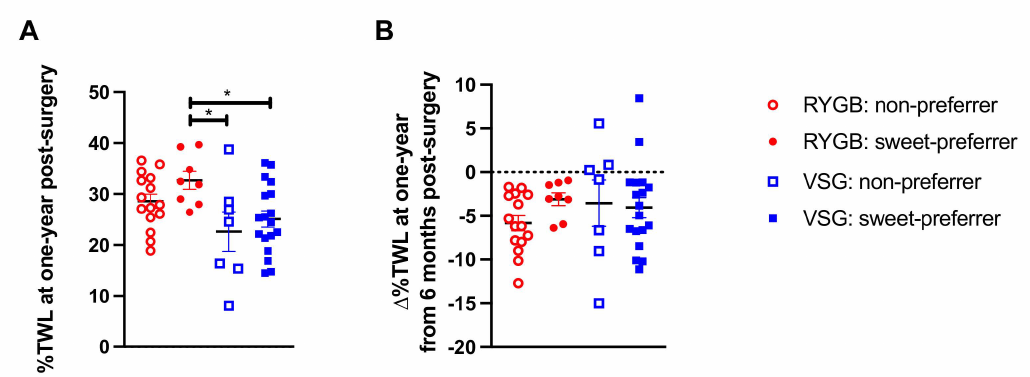
Figure 3. ( A ) Mean ± SEM %TWL at one year following surgery in patients who received RYGB (red circles) or VSG (blue squares) and rated the 10% sucrose-sweetened half-and-half mixture with a 0–50 score at baseline (open shapes) or rated the 10% sucrose-sweetened half-and-half mixture with a 51–100 score at baseline (closed shapes). ( B ) Mean ± SEM ∆ %TWL from six months to one year following RYGB (red circles) and VSG (blue squares) and rated the 10% sucrose-sweetened half-and-half mixture with a 0–50 score at baseline (open shapes) or rated the 10% sucrose-sweetened half-and-half mixture with a 51–100 score at baseline (closed shapes), where positive values indicate weight gain and negative values indicate weight loss. * p < 0.05 Bonferroni-corrected